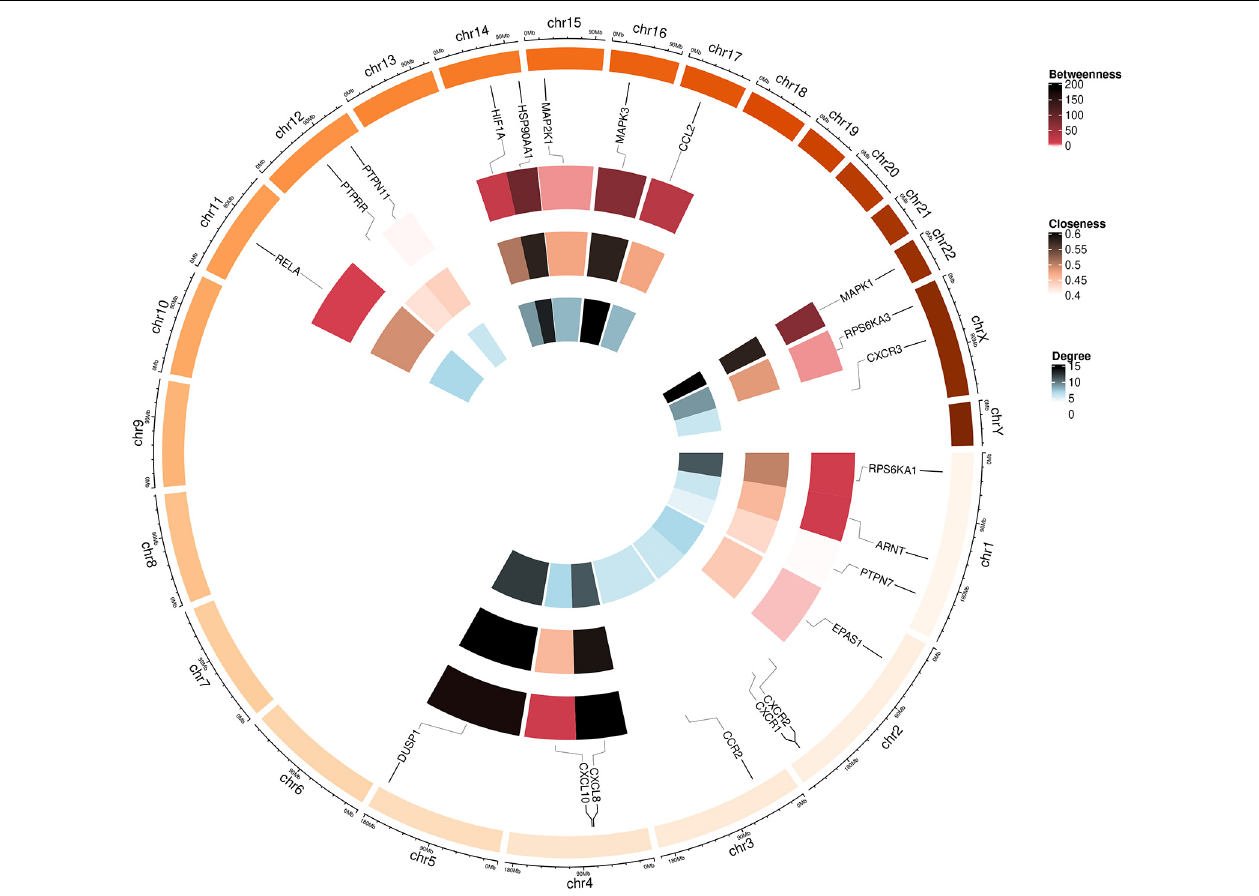
FIGURE 5 | Circular visualization of the chromosomal positions and connectivity of polydatin-targeted genes. Gene names are shown in the outer circle. In the outer heatmap, deep color represents high betweenness, in the middle heatmap, deep color represents high closeness, and in the inner heatmap, deep color represents high degree. Lines extend from each gene point to its specific chromosomal locatio on the chromosomal circle.